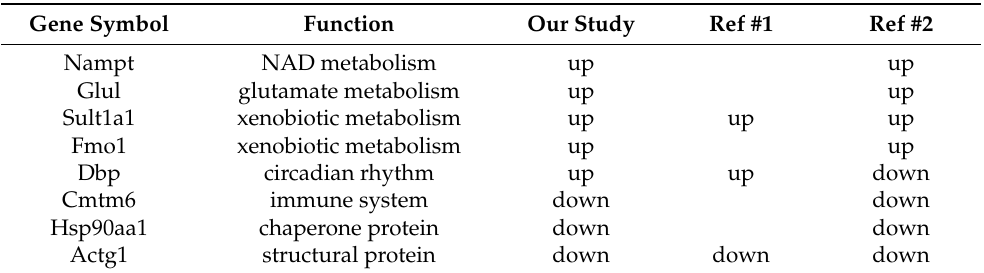
Table 5. The overlap of top-ranked genes commonly regulated by CR across all tissues with previous meta-analyses